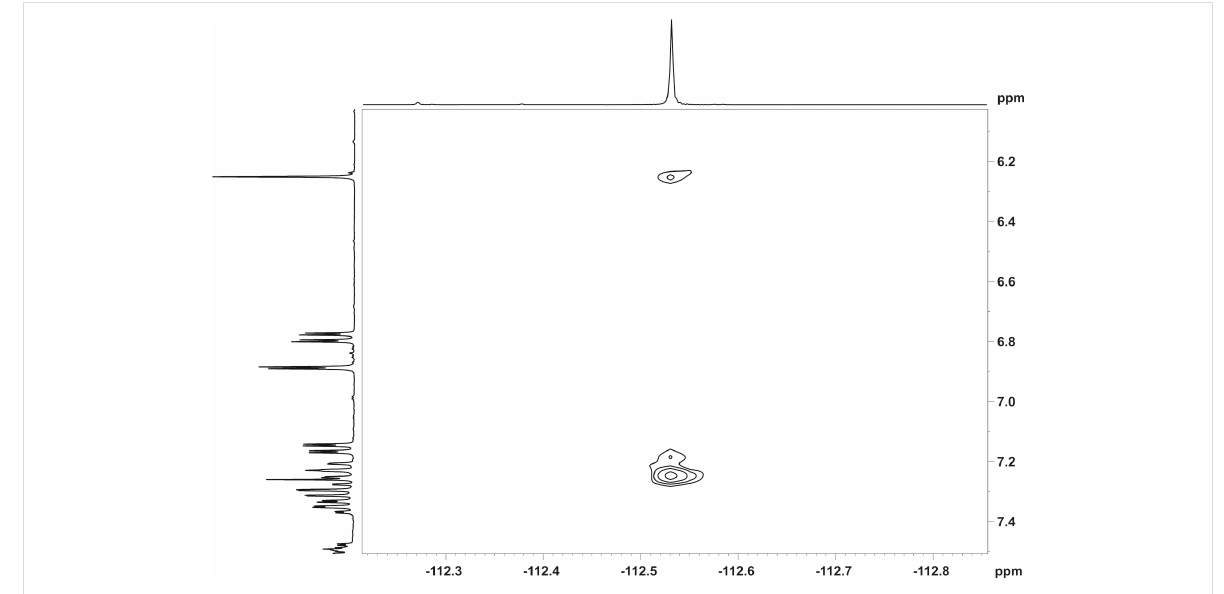
Figure 3: 19 F, 1 H-HOESY NMR spectrum for coumarin 6 illustrating two through-space interactions.